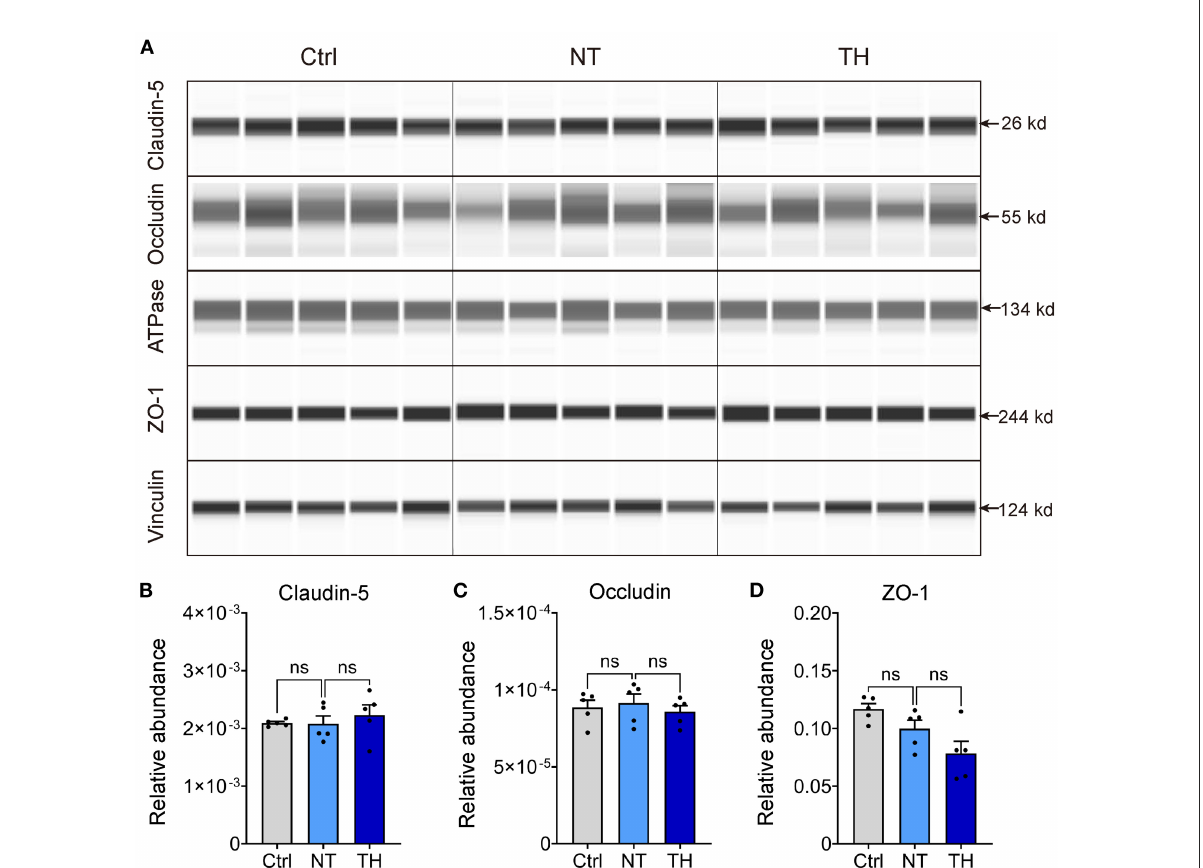
FIGURE3 The expression change of endothelial tight junctions (TJ) with TH 4h post-SCI. (A) Representative virtual lanes of capillary western blot analysis of TJ with TH 4h post-SCI. These virtual lanes were generated from the ProteinSimple TM system but not used for quantification. ATPase and vinculin were used as loading controls. (B) Quantification of the relative expression of claudin-5 with TH 4h post-SCI ( n = 5 mice per group, Ctrl & NT: P = 0.995, NT & TH: P = 0.856). (C) Quantification of the relative expression of occludin with TH 4h post-SCI ( n = 5 per group, Ctrl & NT: P = 0.99, NT & TH: P = 0.863). (D) Quantification of the relative expression of ZO-1 with TH 4h post-SCI ( n = 5 mice per group, Ctrl & NT: P = 0.28, NT & TH: P = 0.152). Data are shown as mean ± SEM; ns, non-significance; nested, one-way ANOVA with Bonferroni’s post hoc